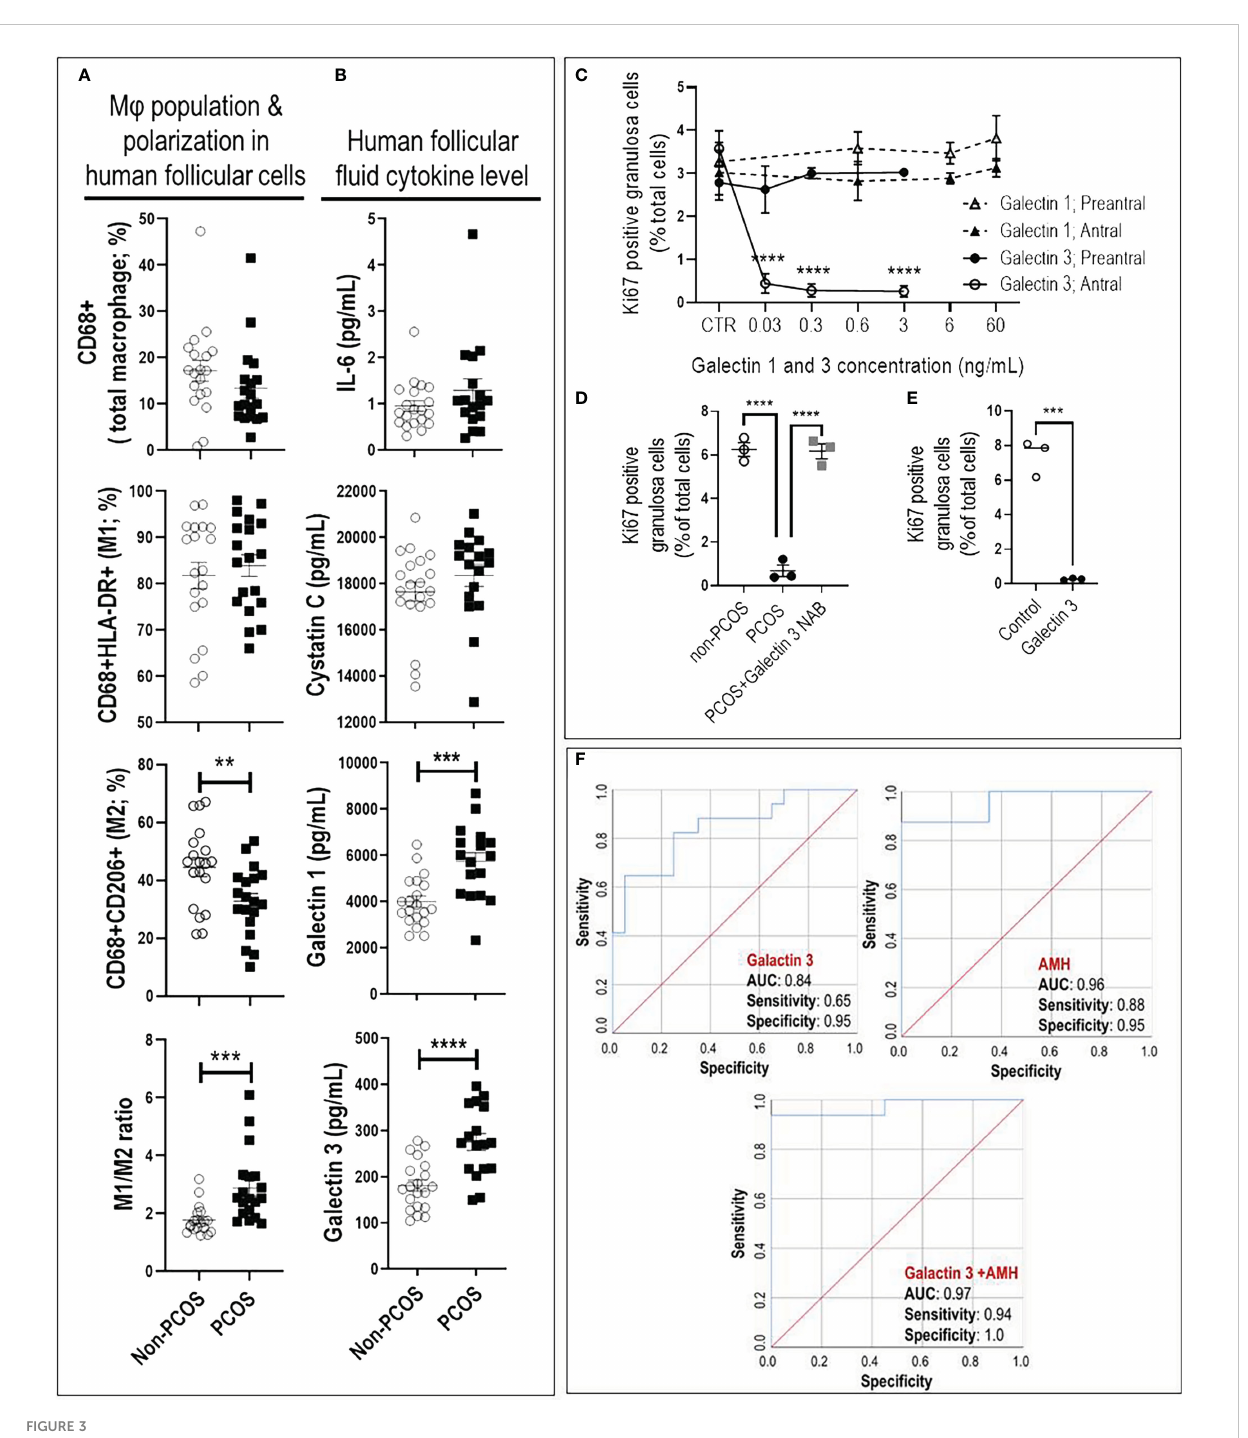
FIGURE 3 Increased M1/M2 ratio and galectin-3 suppresses granulosa cell proliferation in antral, but not preantral follicle stage, as evident in PCOS. (A) PCOS subjects had lower M2 population and higher M1/M2 ratio compared to non-PCOS; (B) PCOS subjects had higher FF content of galectin-1 and -3 compared to non-PCOS; (C) Galectin-1 did not affect rat GC proliferation in preantral and antral follicles, galectin-3 signi fi cantly reduced GC proliferation in antral but not preantral follicles; (D) Adding PCOS FF to non-PCOS GCs signi fi cantly reduced cell proliferation compared to those treated with non-PCOS FF. However, the effect of PCOS FF on GC proliferation was blocked using galectin-3 neutralizing antibody; (E) Adding human recombinant galectin-3 to non-PCOS GCs signi fi cantly suppress proliferation; (F) The combination of galectin-3 and Anti-Müllerian hormone (AMH) improve sensitivity and speci fi city of PCOS prediction compared to AMH. AMH: AUC=0.96 with sensitivity=0.88 and speci fi city=0.95 (p<0.0001); Galectin-3: AUC=0.84 with sensitivity=0.65 and speci fi city=0.95 (p<0.001); Galectin-3+AMH: AUC=0.977 with sensitivity=0.94 and speci fi city=1 (p<0.0001). Results are expressed as mean±SEM (n=3 replicates each with 2 rats/group). Data were analyzed by two-way ANOVA and tukey post hoc. ** P <0.01, *** P <0.001, **** P